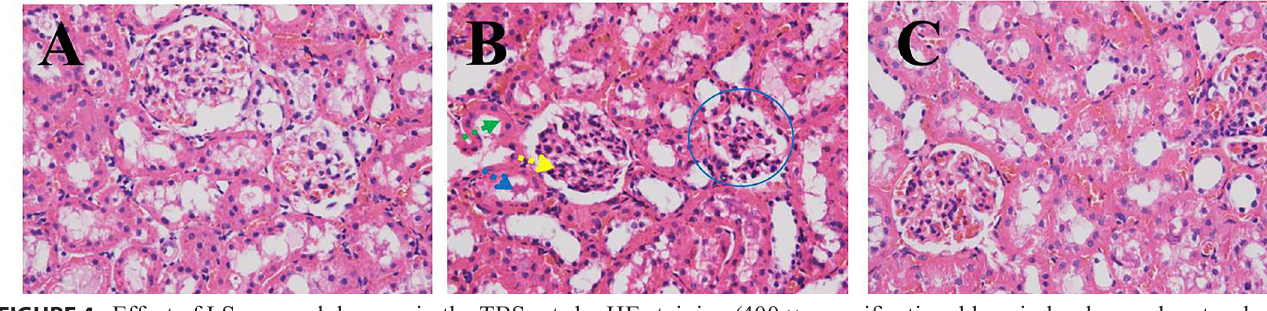
FIGURE 4 - Effect of LS on renal damage in the TBS rats by HE staining (400 × magnification, blue circle-glomerular atrophy, blue arrow-renal tubular epithelial cell, green arrow-capillary, yellow arrow-inflammatory cell). (A) control group; (B) TBS group; and (C) LS